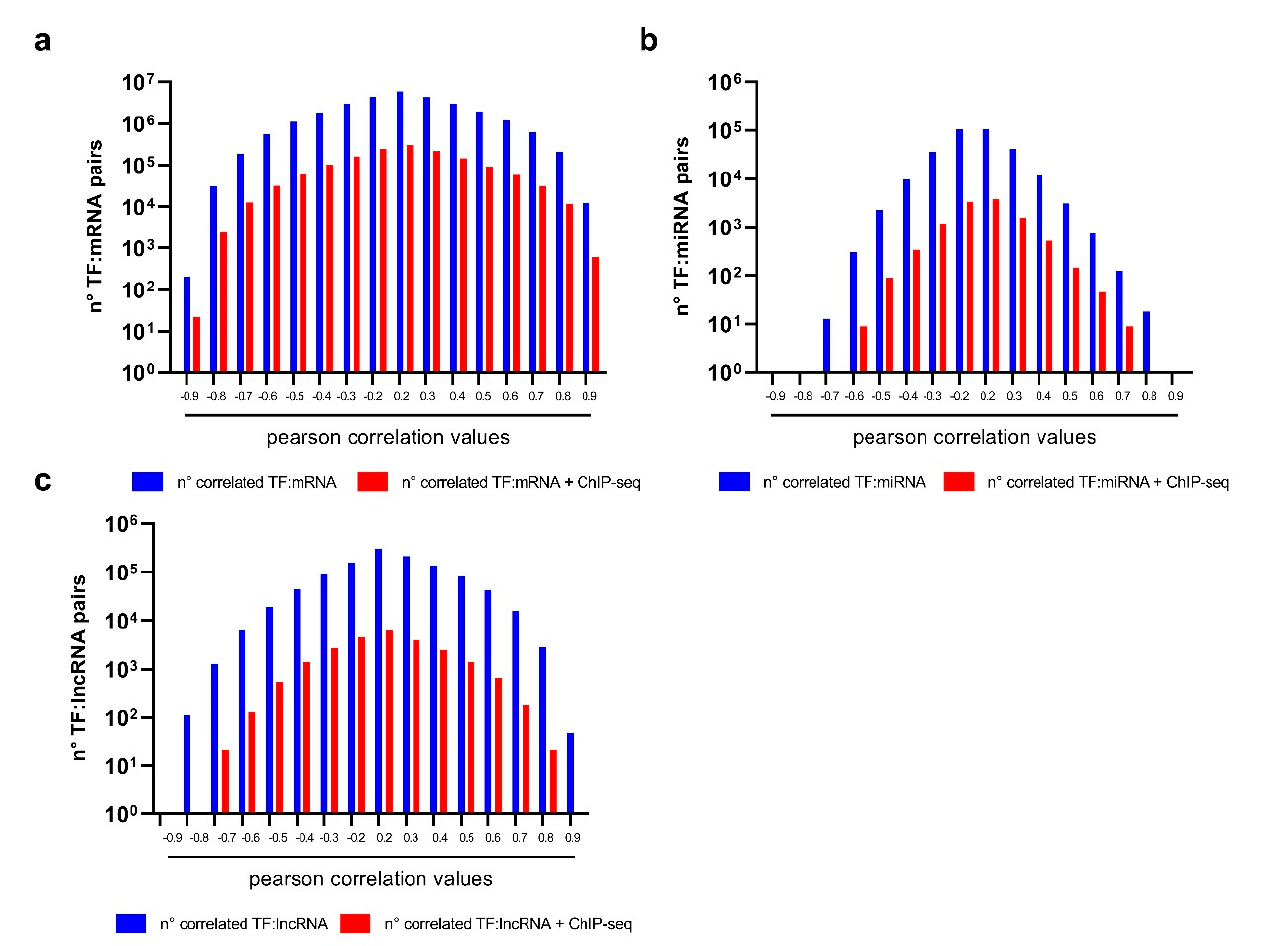
Figure 9. Transcription factors and their potential targets in uveal melanoma retrieved by VECTOR. TFs regulating ( a ) mRNA coding genes, ( b ) miRNA coding genes, ( c ) lncRNA coding genes are reported according to correlation coefficients as the number of correlated TF:xRNA pairs (blue bar) and the number of correlated TF–xRNA pairs whose TF potentially binds the promoter of xRNA genes (red bar).